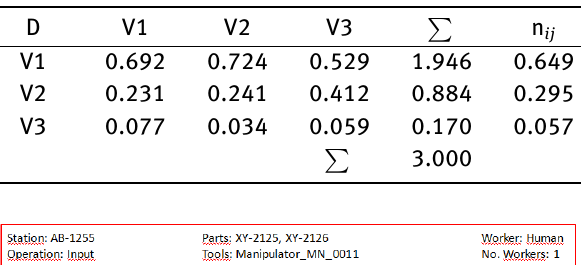
Table 12: Calculation of effectiveness in accordance with develop- ment diflculty.